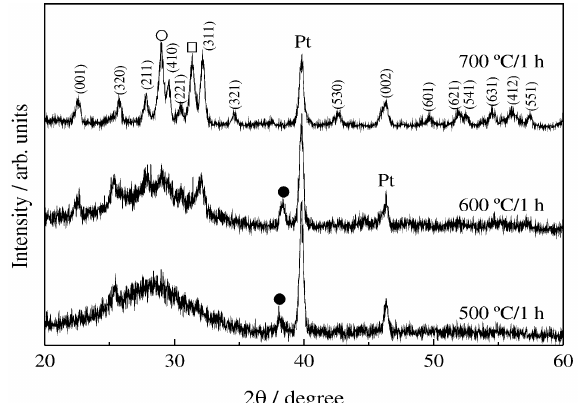
Figure 1. X-ray diffraction patterns of SBN thin films deposited on Pt/Ti/SiO 2 /Si substrate. Films were crystallized at 500 °C, 600 °C and 700 °C (C) for 1 h. In this figure SrNb 2 O 6 (O), TiO 2 ( ) and metallic Ti ( •